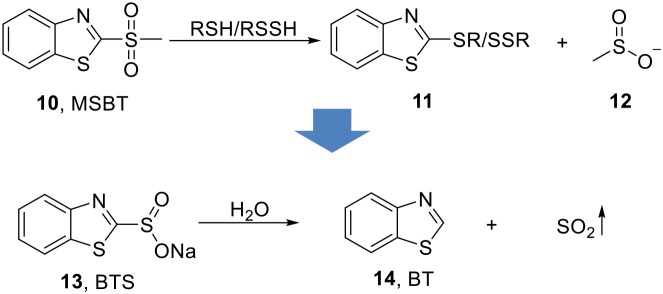
Hydrolysis-based SO2 prodrug.